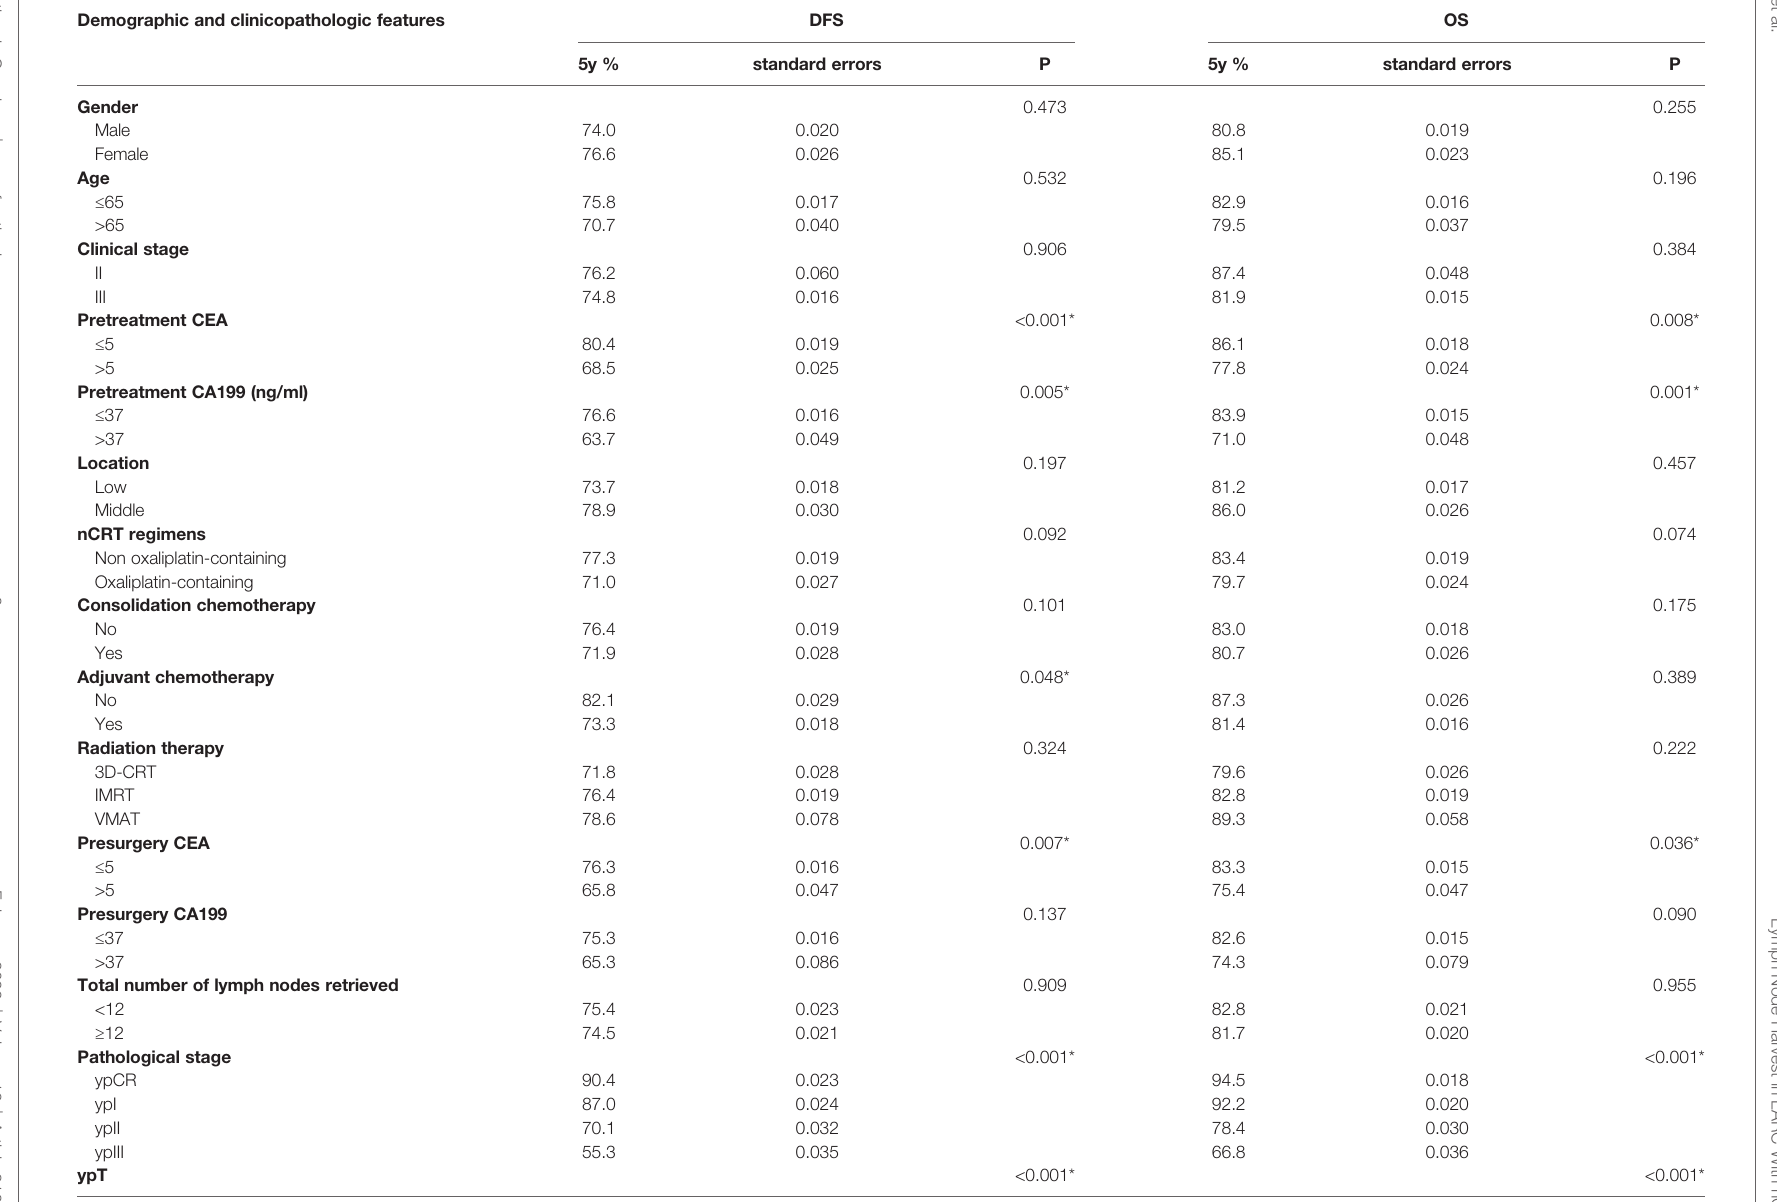
TABLE 2 | Univariate analysis of prognostic factors (OS and DFS) in 837 patients. Demographic and clinicopathologic features